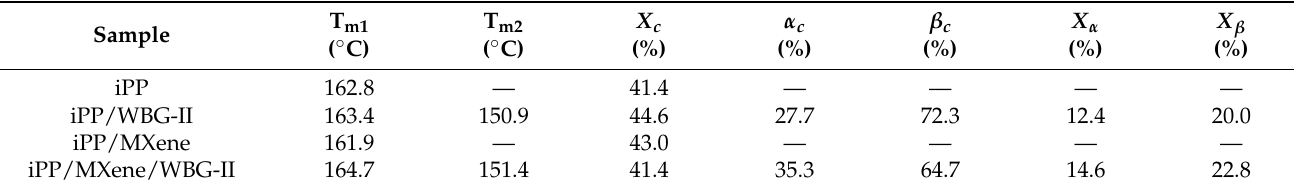
Figure 7. DSC heating curves of four samples. Table 1. The heating curve parameters of four samples, where T m1 and T m2 are the peak melting temperature of the α - and β -phase, X c is the degree of crystallinity, α c and β c are the relative percentage of α - and β -crystals, X α and X β are the crystallinity of α - and β-crystals.